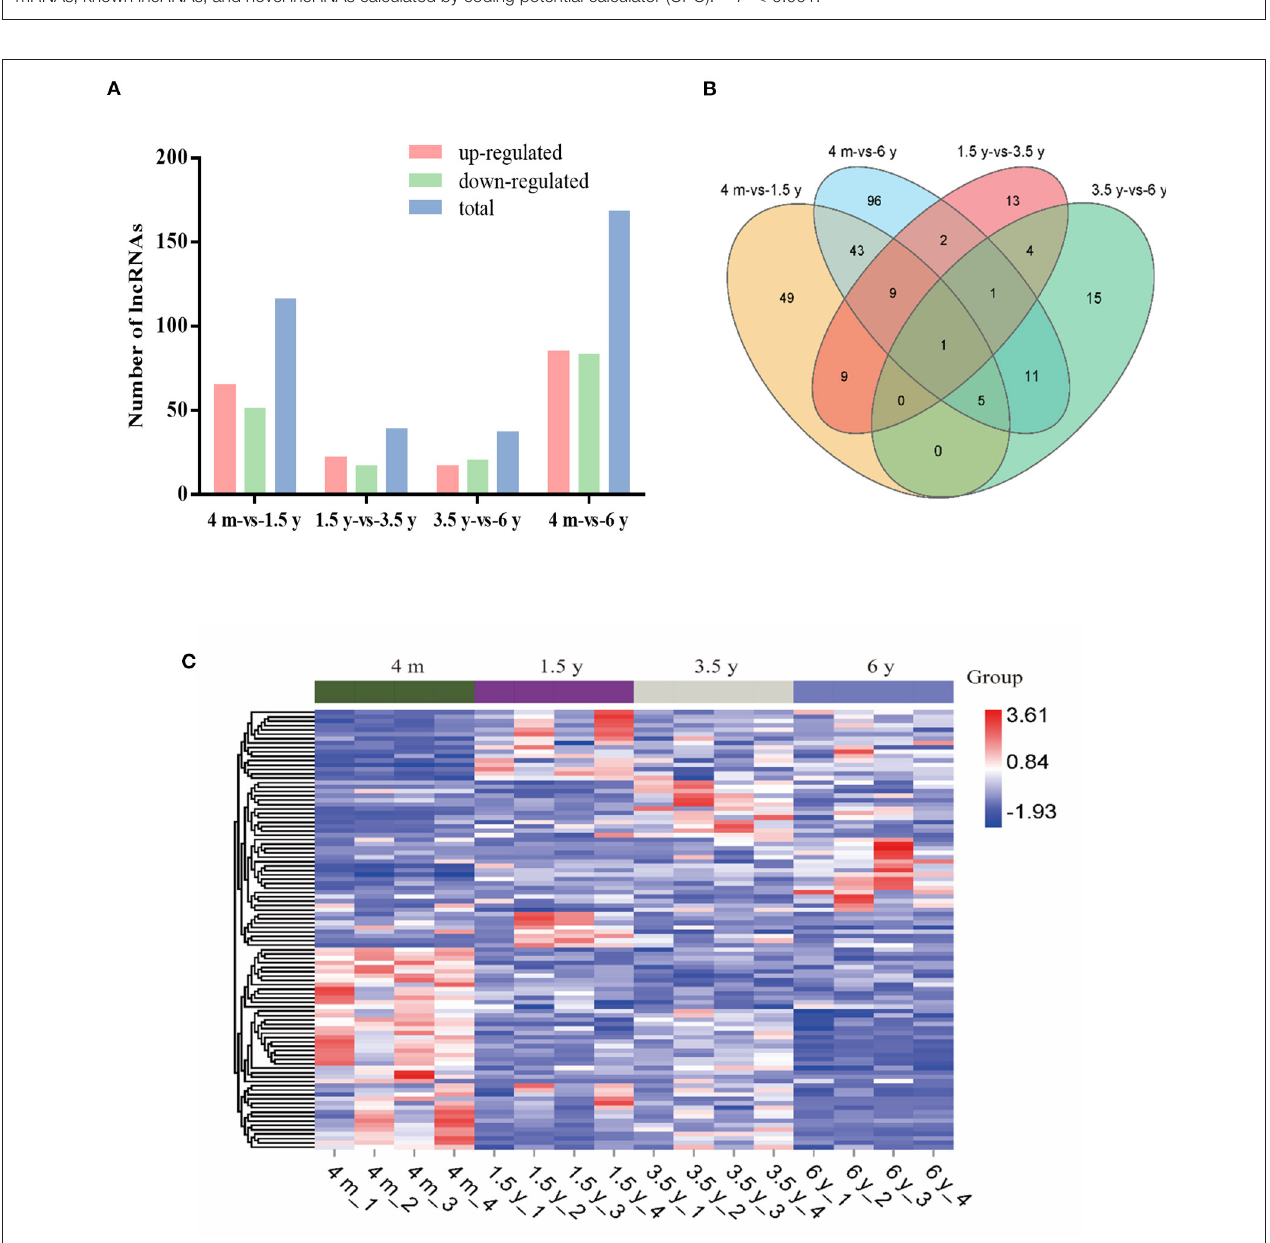
FIGURE 4 | Analysis of the differentially expressed (DE) lncRNAs in the muscle of Tibetan sheep at different ages. (A) Statistical histogram of DE lncRNA in four contiguous period transcriptome comparative groups. (B) The Venn diagrams of the shared and unique differential lncRNAs in the four comparative groups. (C) Cluster heat map of DE lncRNA expression. Red means upregulation and blue means downregulation.